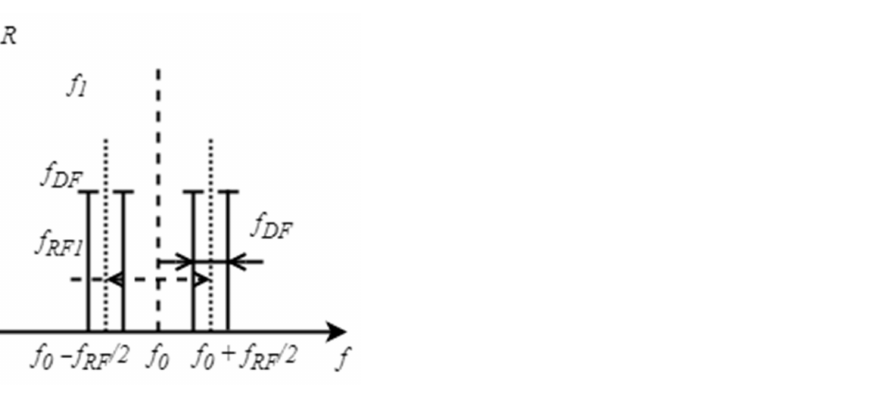
Figure 6. IFM method with increased resolution at “high” frequencies: explanation of the operation principle (adapted from